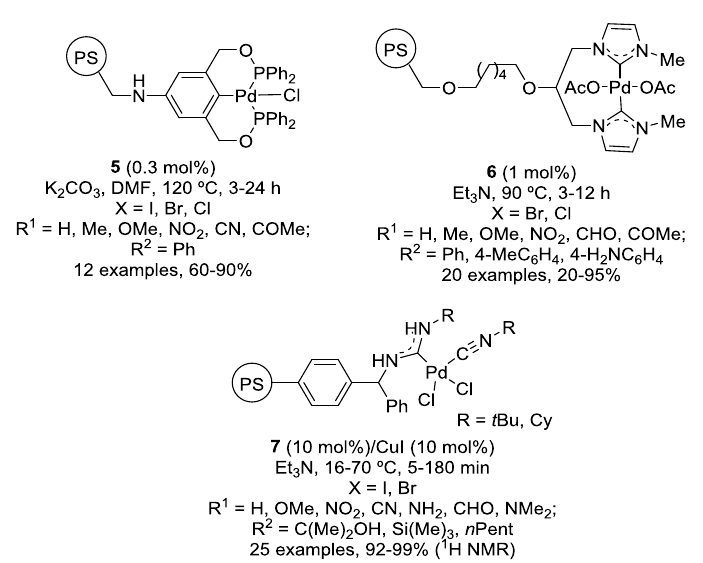
Figure 2. Polystyrene-supported palladium catalysts for the Sonogashira reaction. Conditions, substrate scope and yield range (Scheme 2).